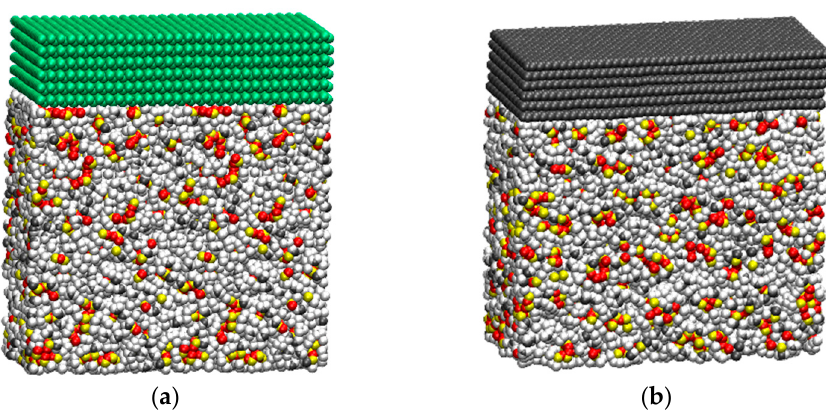
Figure 1. Constructed molecular models of six layers of borophene ( a ) and graphene ( b ) stacked over PDMS polymer within the simulation box cell. Color coding, includes; boron in green, carbon in dark grey, hydrogen in white, oxygen in red and silicon in yellow.